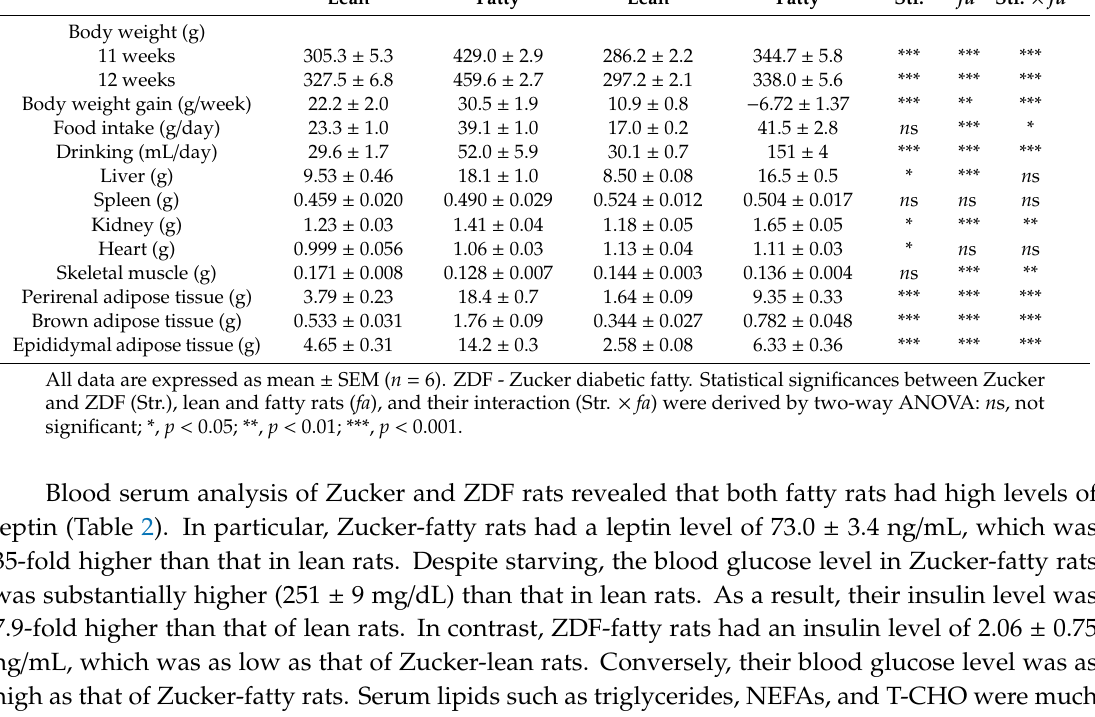
Table 1. Body weight, food intake, drinking, and tissue weights in rats. Zucker ZDF Two-way ANOVA Lean Fatty Lean Fatty Str. fa Str. × fa